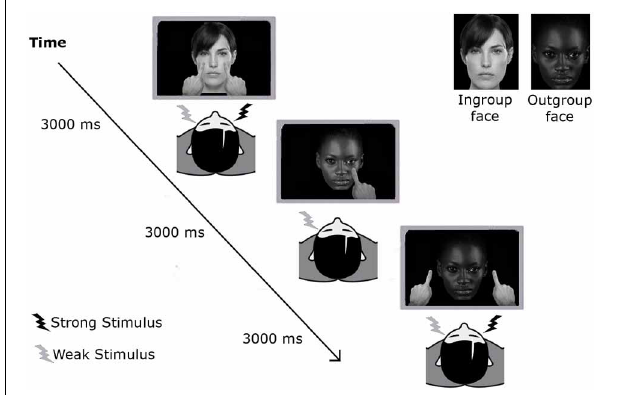
FIGURE 1 | Experimental paradigm in Experiment 1. Participants performed three randomized blocks of tactile confrontation task, lasting ∼ 3min each. In each trial a different image (either an Ingroup or an Outgroup face) was presented in the video, where fingers moved toward the image and then backwards to their starting position. Fingers either touched the cheeks of the shown face or stopped 5cm alongside the face. As soon as the fingers reached the image, a tactile input was delivered on the participants’ cheeks. Participants were asked to indicate the side on their face in which they felt the tactile stimulation, regardless of visual